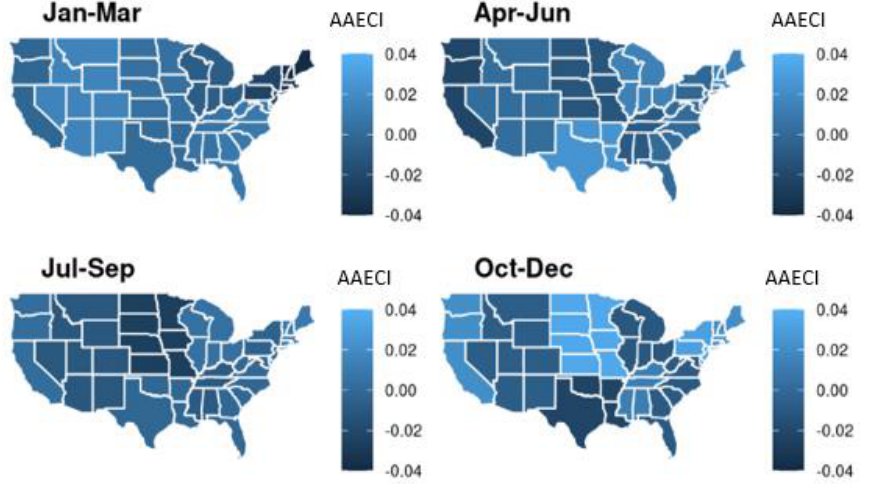
Figure 1. Aggregate adjusted excess coding intensity (AAECI) by quarter and U.S. Census regional division for 2019.